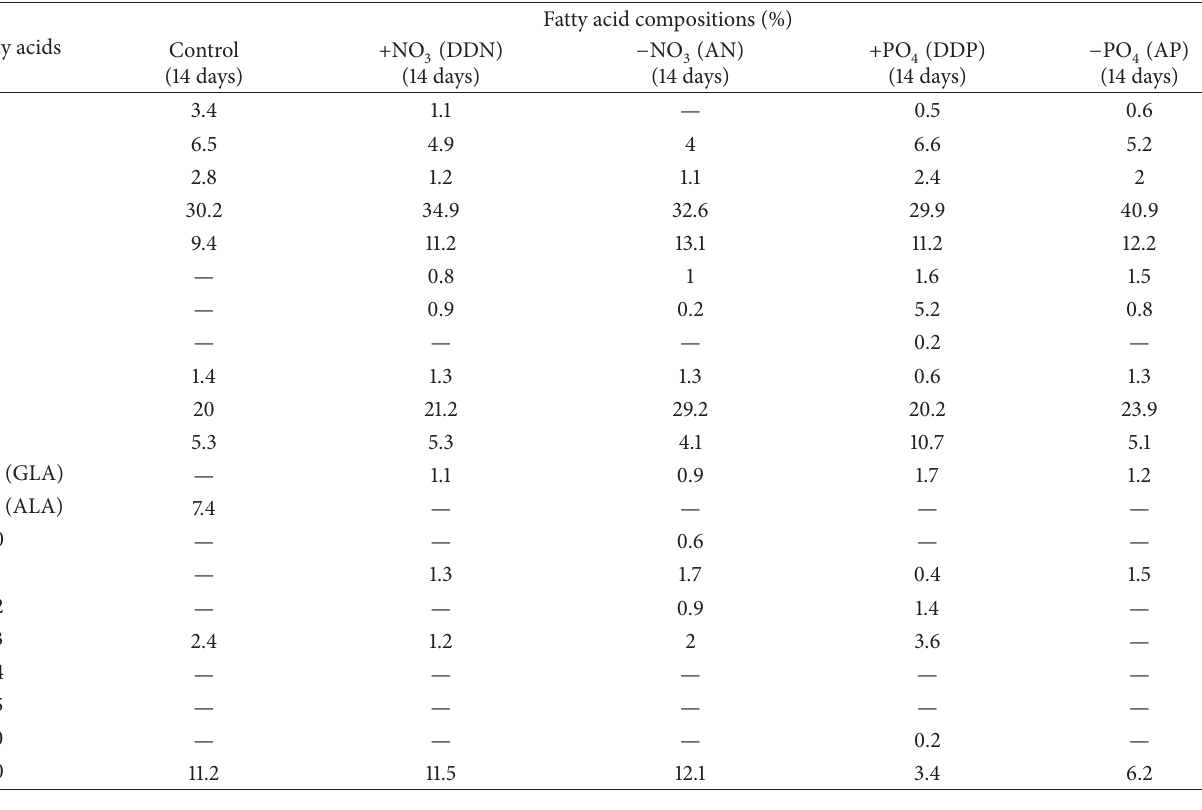
Table 1: Showing fatty acid compositions (%) of both control and treated cells (DDN, AN, DDP, and AP) of R . africanum at log-exponential phase (14-day-old culture).